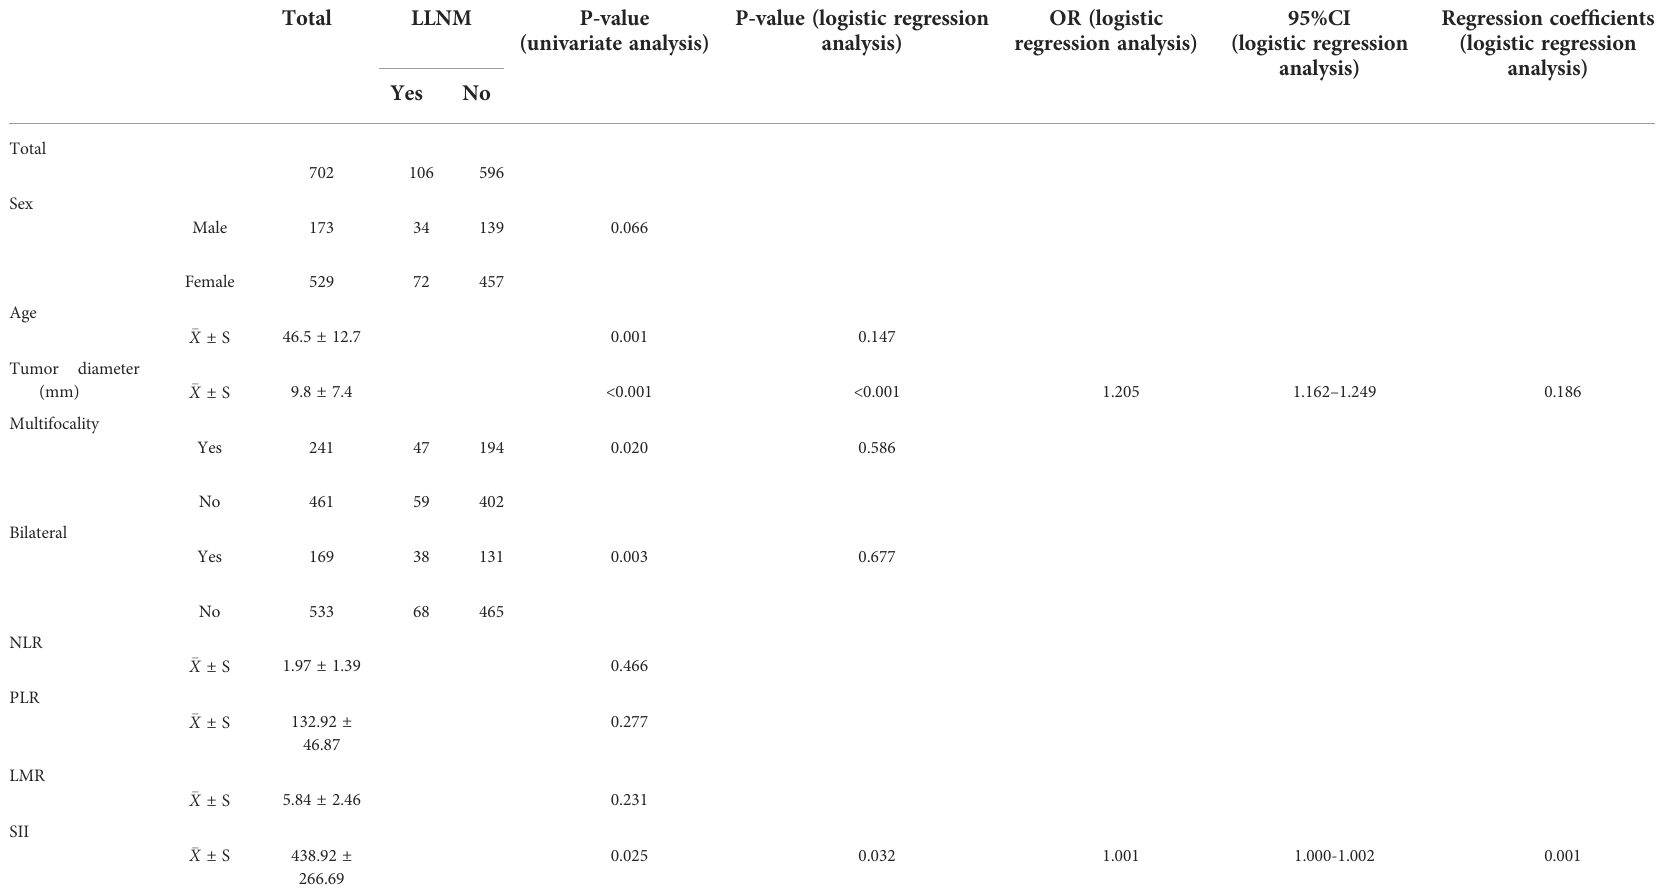
TABLE 2 General information and results of univariate logistic regression analysis of 702 papillary thyroid carcinoma